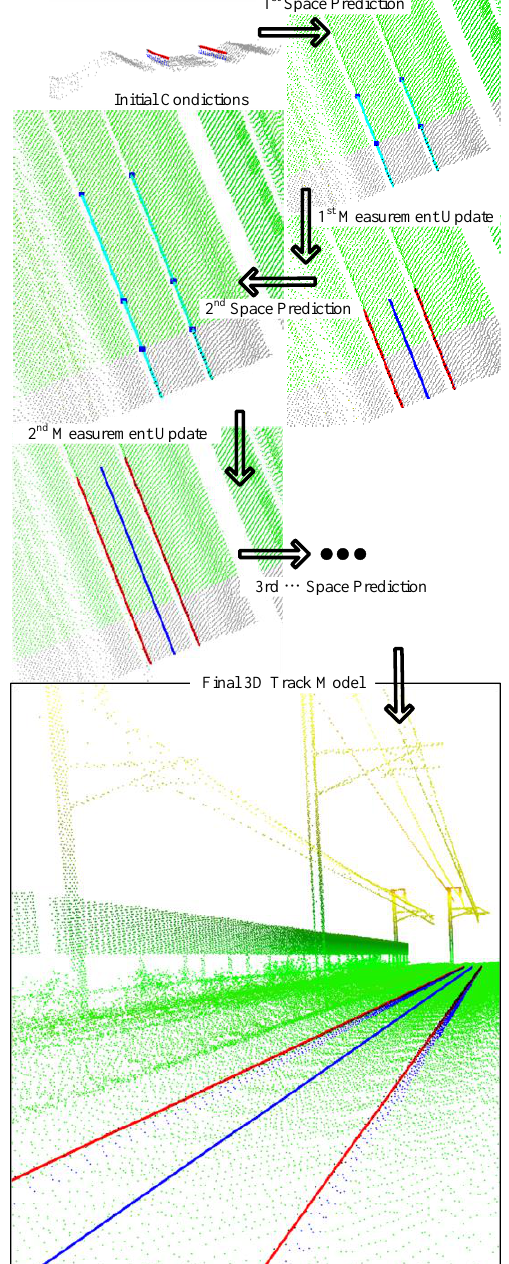
Figure 6. Kalman filter-based railway tracking procedure for detecting track points (blue color), 3D track model (red color), and track center line (blue